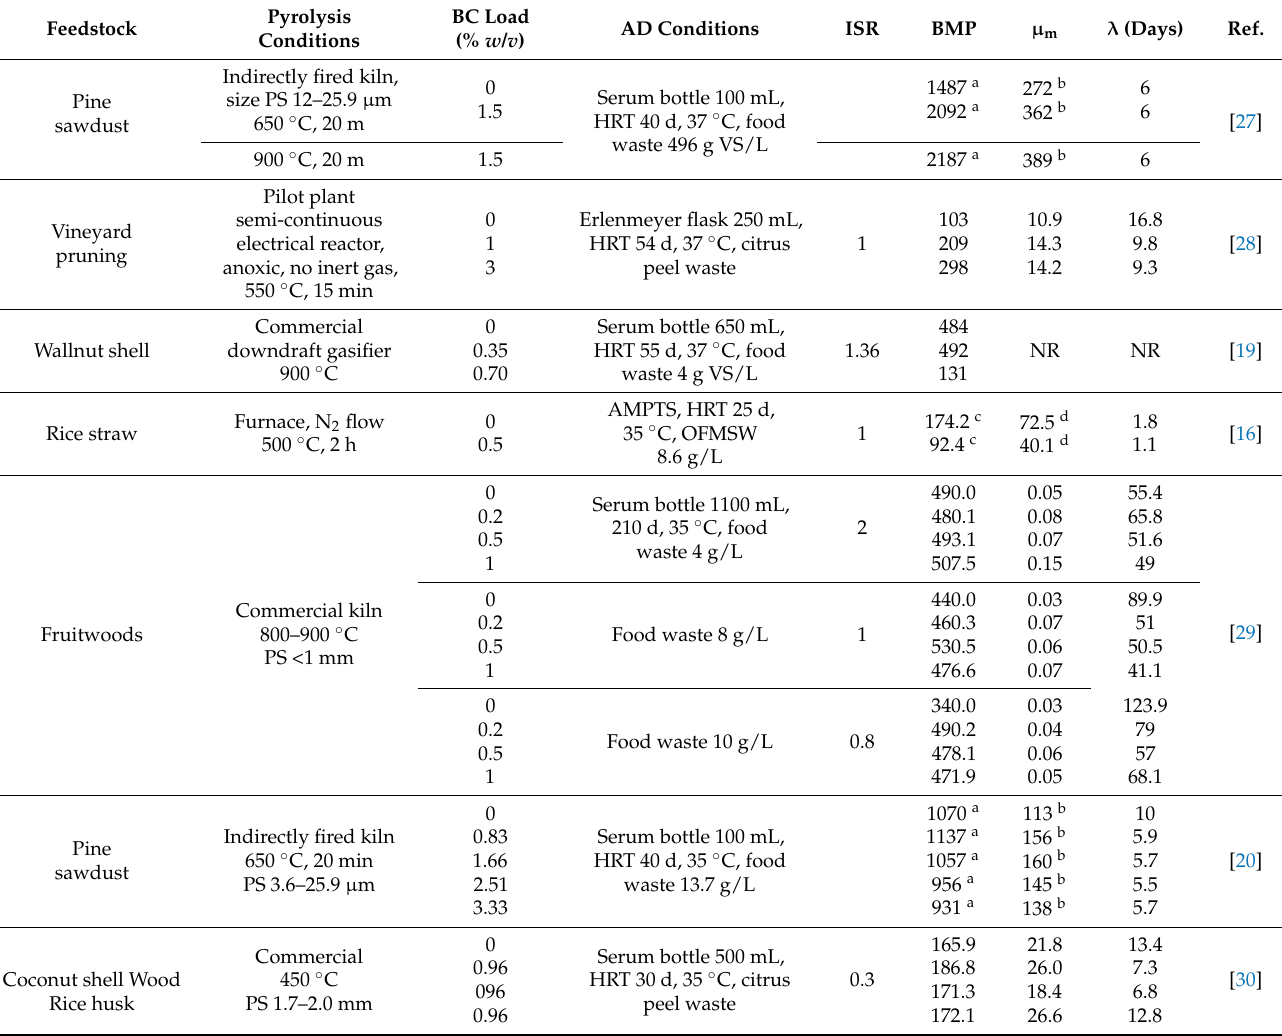
Table 2. Summary of the reports for the biochar addition on anaerobic digestion of food waste and organic fraction of the municipal solid waste